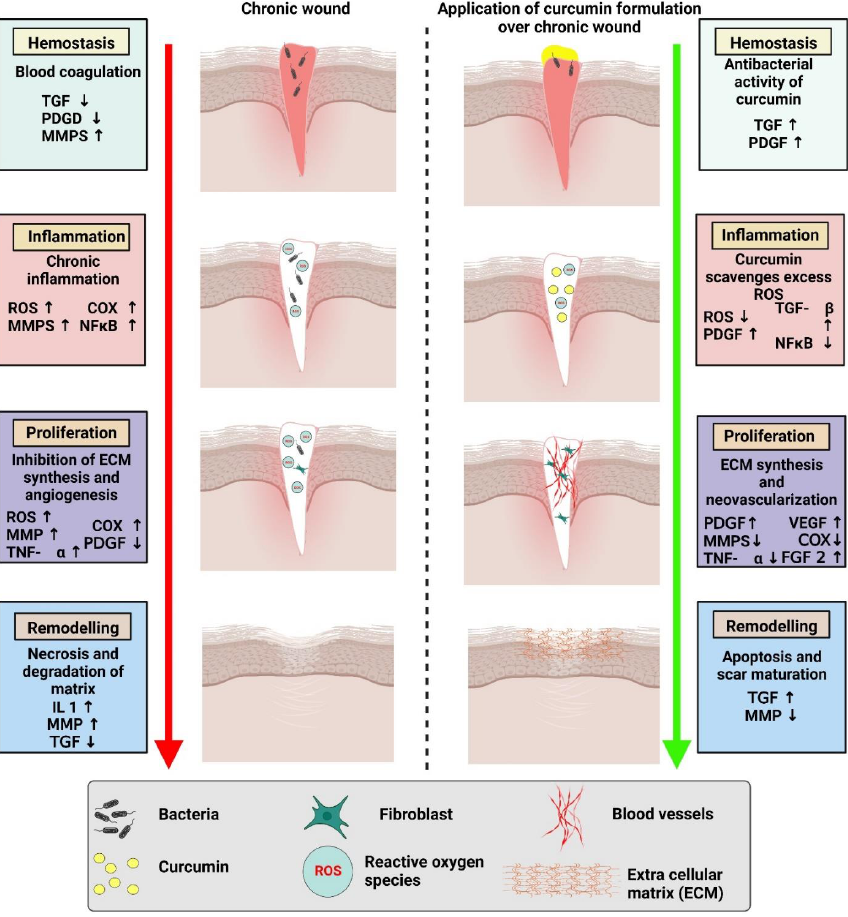
Figure 2. Comparison of chronic wound healing and accelerated wound healing with the application of a curcumin-based formulation.